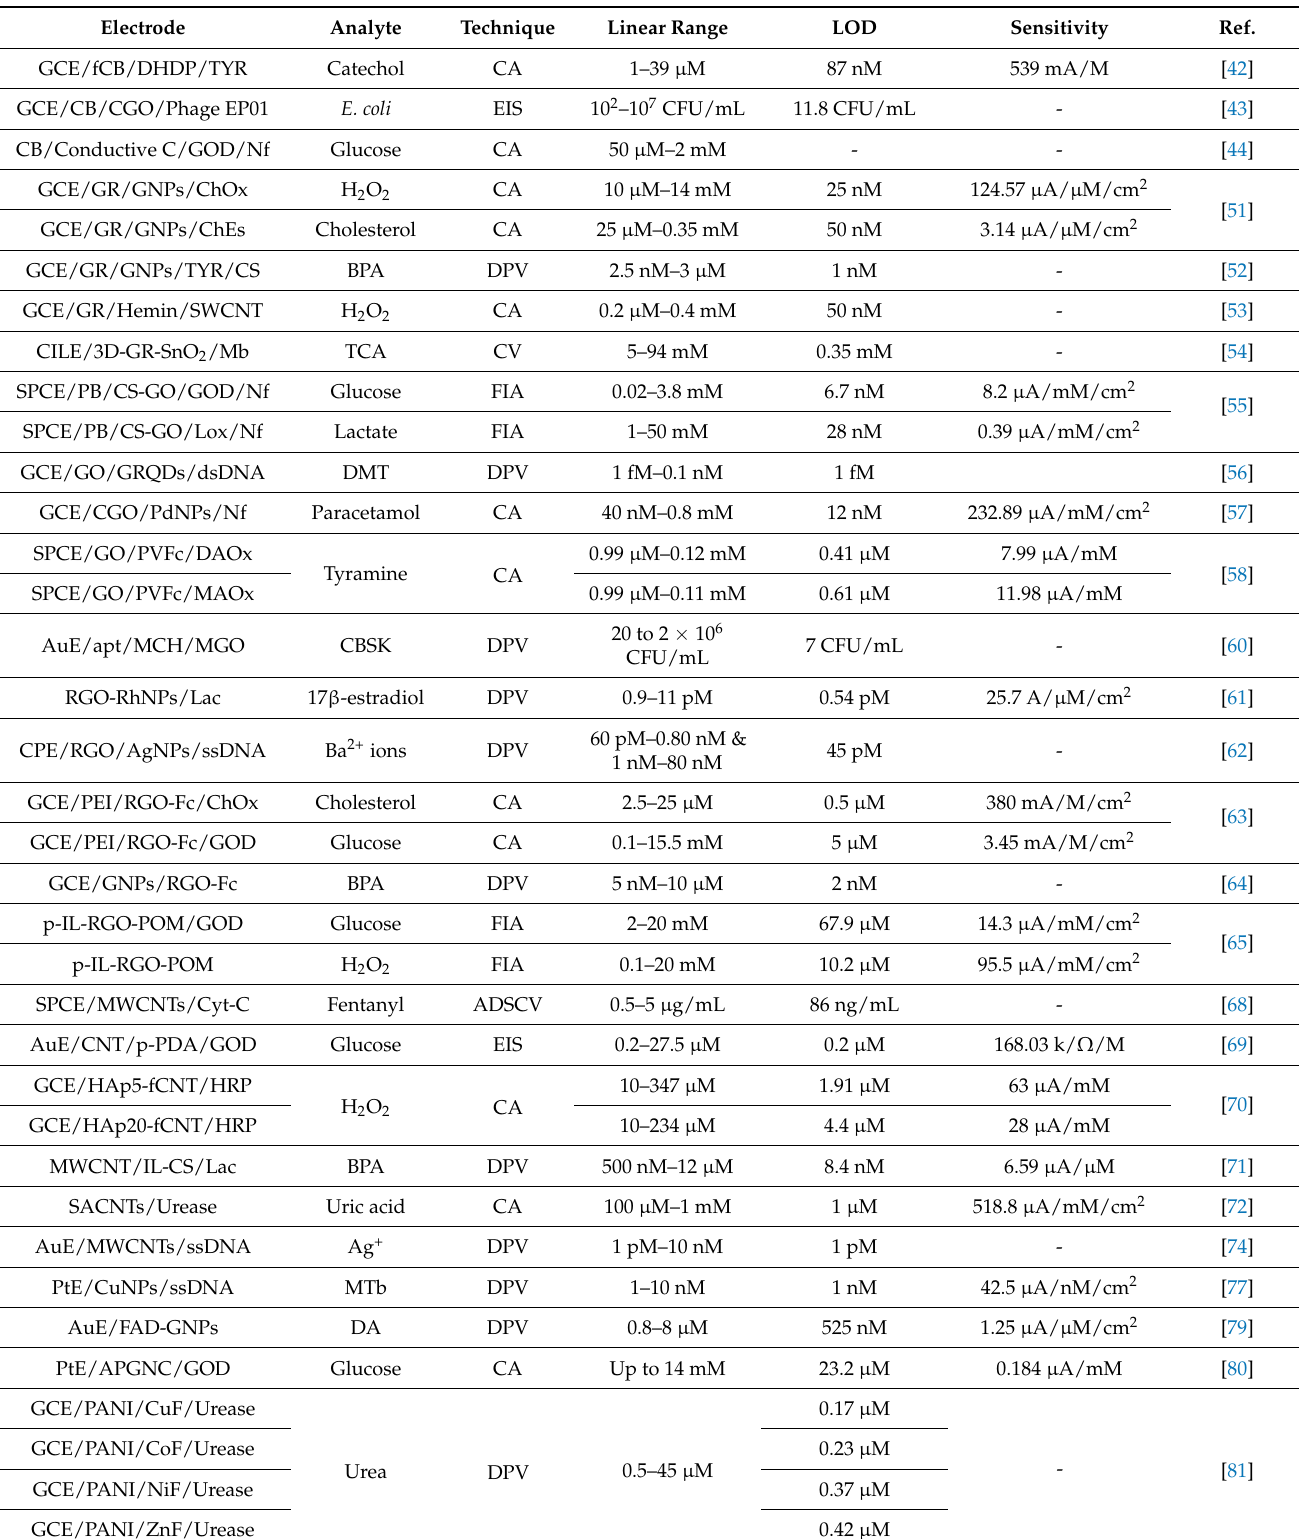
Table 1. Electrocatalytic performance of various nanomaterials based electrochemical biosensors. Electrode Analyte